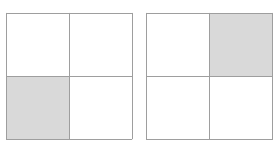
Figure 6: Example of the packed phase on a 2 × 4 × 4 lattice; spheres represent spins that are up, and empty spaces denote spins that are down. Domain walls are explicitly shown, and different clusters have been given different (randomly chosen)